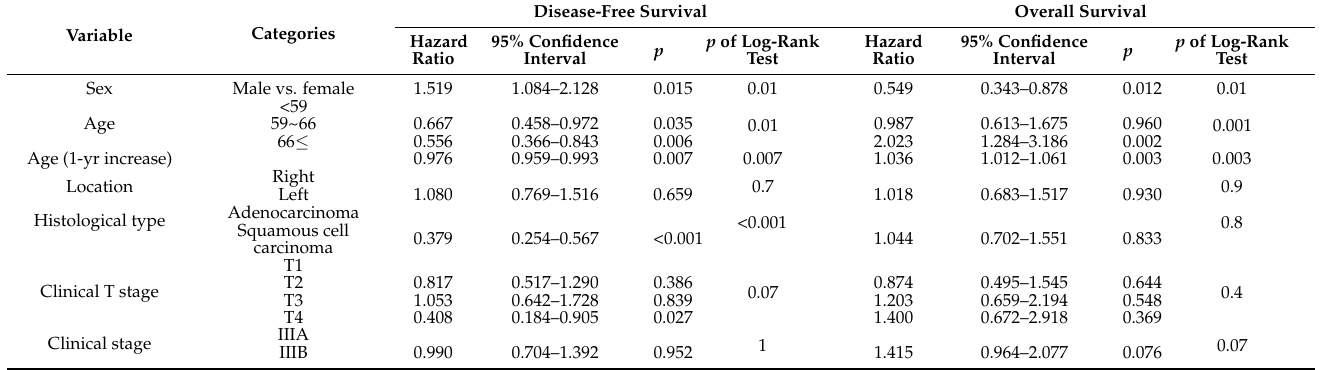
Table 2. Univariate Cox regression analysis for